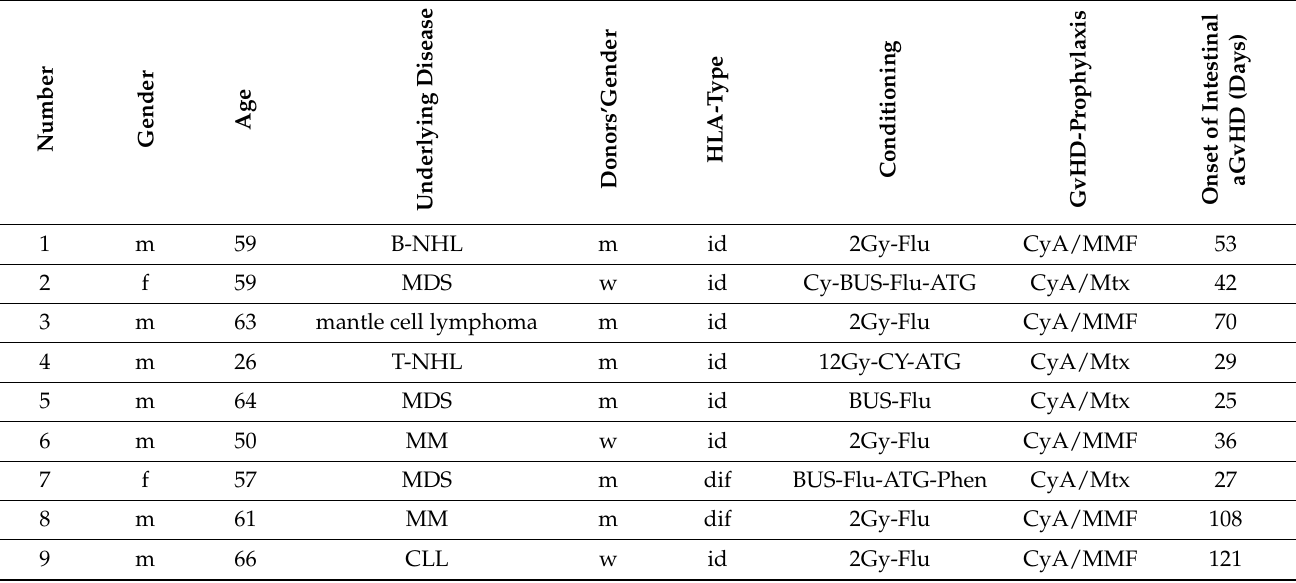
Table 1. Overview of all patients with acute intestinal GvHD after aHSCT.